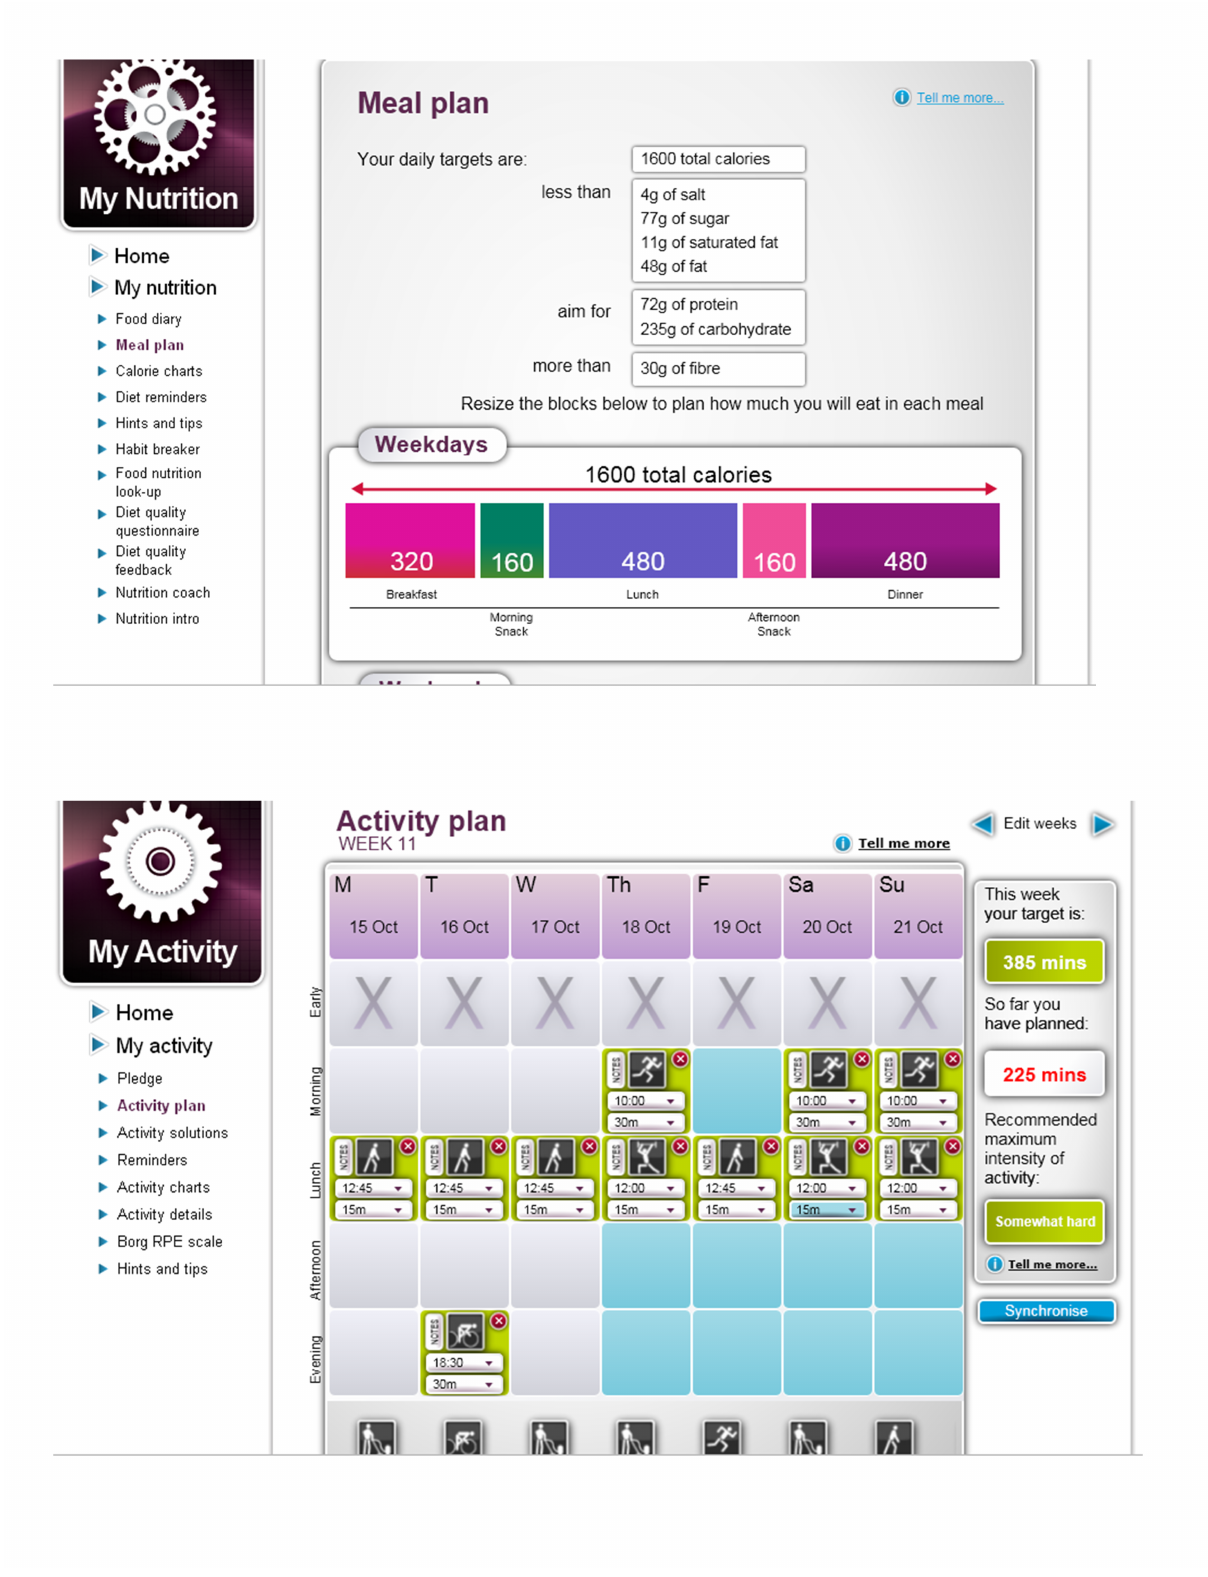
Figure 1. Imperative Health screenshots of meal and activity